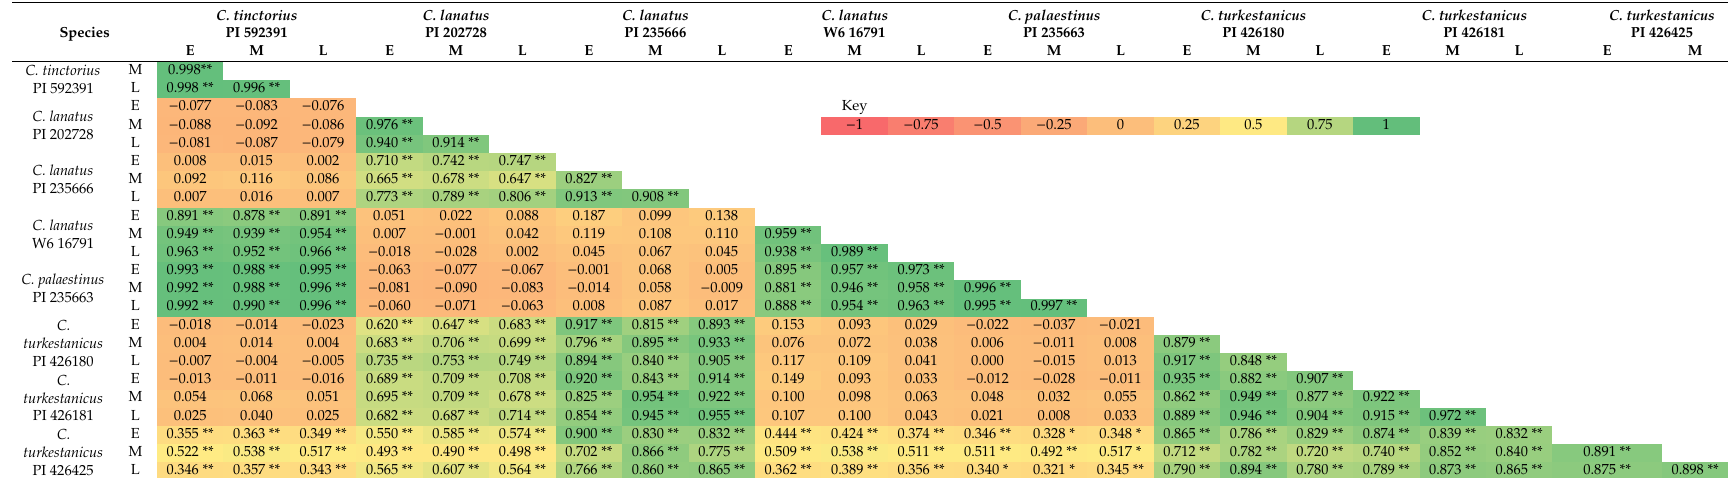
** Correlation significant at p < 0.01 (two-tailed). *Correlation significant at p < 0.05 (two-tailed). Sample name abbreviations: the first two letters indicate the first two letters of the species name, the number indicates the last digit of the PI number, and the letters E, M, and L indicate early, middle, and late stages of development, respectively. For example, “ti1E” indicates the sample PI 592391 ( C . tinctorius ) at the early stage of